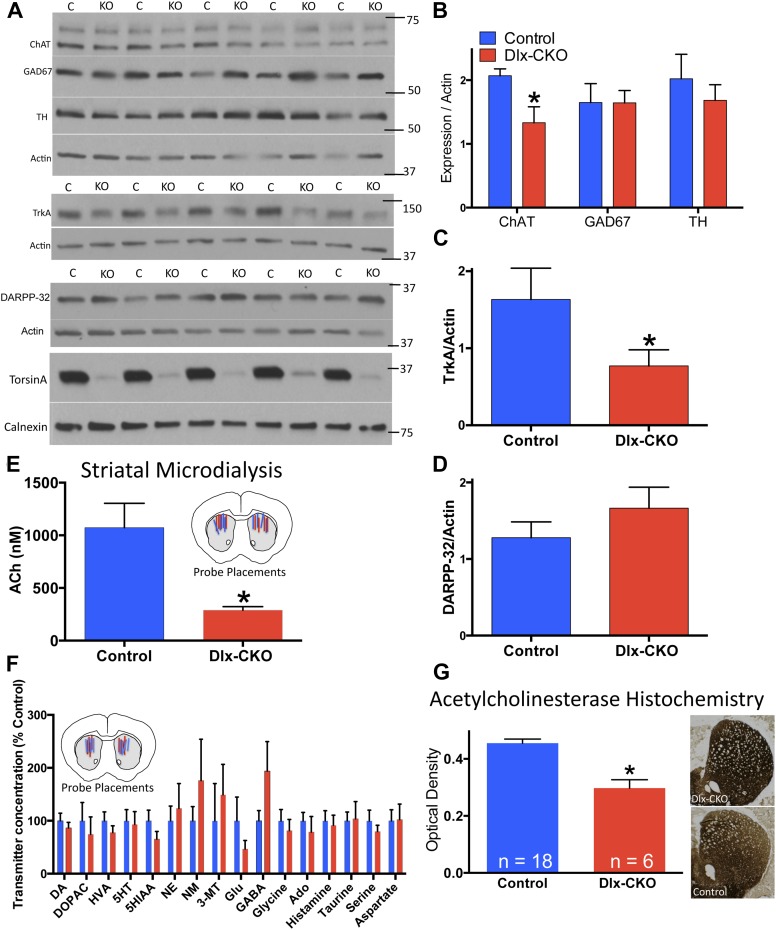
Cholinergic-specific abnormalities in the striatum of Dlx-CKO mice.(A) Western blots of microdissected striatum from 10 week old control and Dlx-CKO mice for markers of cholinergic, GABAergic, and dopaminergic signaling. (B–D) Quantification of the western blots demonstrated a selective reduction of LCI markers choline acetyltransferase (t-test: t (8) = 2.683; p = 0.013) and TrkA (t(8) = 1.883; p = 0.048). No differences were observed for markers of GABAergic or dopaminergic neurons (GAD67; t(8) = 0.012; p = 0.99; TH; t(8) = 0.742; p = 0.47; DARPP-32; t(8) = 1.12; p = 0.29). (E) Microdialysis and HPLC-MS analysis demonstrates a significant reduction of ACh in dorsal striatum of Dlx-CKO mice (t-test: t(12) = 3.895; p = 0.002; data reported as dialysate concentration and represent the average of 3 fractions per animal following neostigmine perfusion; n = 6–8 probes/group from 4 mice/group). (F) Microdialysis followed by benzoyl chloride derivatization and analysis by LC-MS demonstrated no significant change in any dorsal striatal neurotransmitter examined (basal values measured in absence of Acetylcholinesterase (AChE) inhibitors). Data represent the average of 5 basal collections per animal (n = 7 probes/group from 4 mice/group and are normalized to control levels (two-way ANOVA for genotype: F1,190 = 0.0206; p = 0.88). (G) AChE histochemistry on fresh frozen brain sections demonstrates a significant reduction of striatal AChE in Dlx-CKO mice (t-test; t(22) = 5.16; p < 0.0001). Specificity of AChE reaction was confirmed using several methods (Figure 3—figure supplement 1).